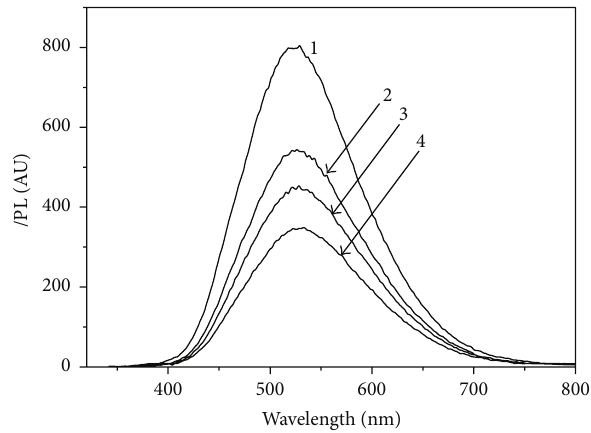
Figure13:TheluminescencespectraofZnOnanoparticlesprepared in the presence of 1g of silica per 10mL of zinc oxide solution, redis- persed in ethanol (1), dimethyl sulfoxide (2), dimethylformamide (3), and ethylene glycol (4). [ZnO] = 2 × 10 −2